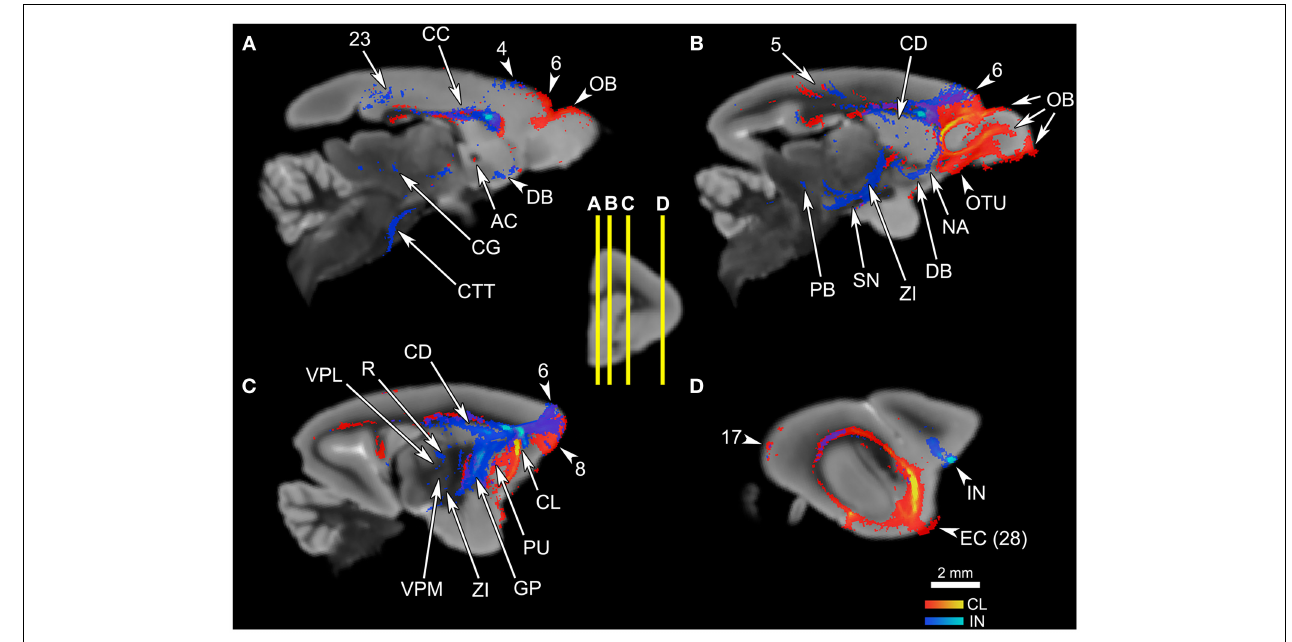
as the parietal cortex.The insular tracts appear in the frontal cortex, parietal cortex, caudate (CD), nucleus accumbens (NA), diagonal band (DB), zona incerta (ZI), substantia nigra (SN), and parabrachial nucleus (PB). (C) The claustrum connects to the frontal cortex and the putamen (PU), while the insula connects to the dorsal frontal cortex, globus pallidus (GP), reticular thalamic nucleus (R), ventral posterolateral thalamic nucleus (VPL), ventral posteromedial thalamic nucleus (VPM), and zona incerta (ZI). (D) The claustrum is highly probably connected to the entorhinal cortex (EC, Area 28 in Le Gros Clark’s 1931 cortical map). Both claustrum and insula are connected to the cortical area 17, although the insula seems connected to a lesser